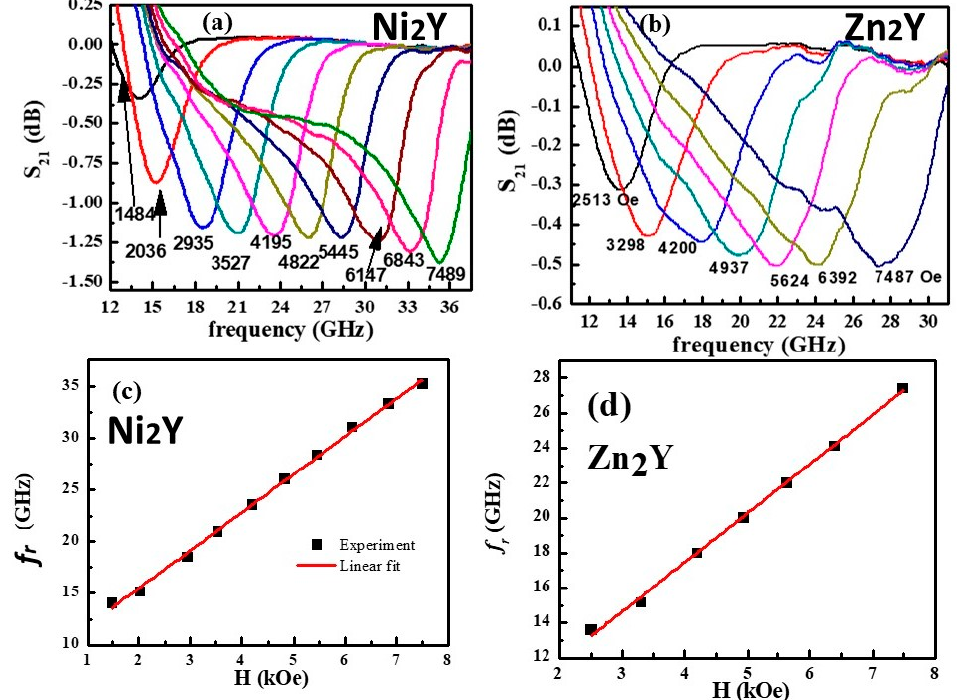
Figure 4. Profiles of scattering parameter S 11 versus frequency f showing ferromagnetic resonance (FMR) for a series of applied static fields H in Oe for discs of fibers of ( a ) Ni 2 Y and ( b ) Zn 2 Y. The field H was applied perpendicular to the plane of the sample. ( c , d ) Resonance frequency f r as a function of H. The straight lines are linear fit to the f r vs. H data.